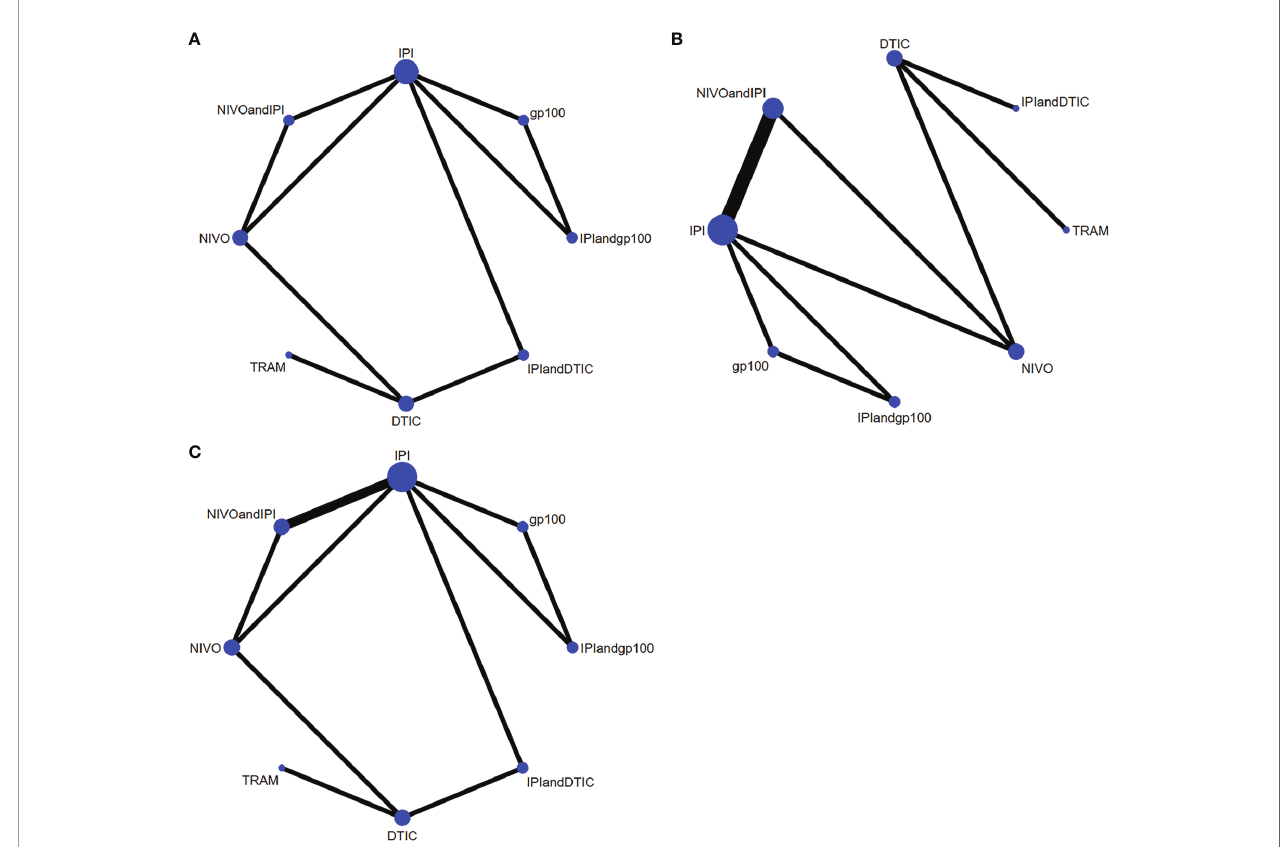
FIGURE 3 | Network constructions for comparisons in OS, PFS and AEs: (A) network constructions for OS, (B) network constructions for PFS, (C) network constructions for